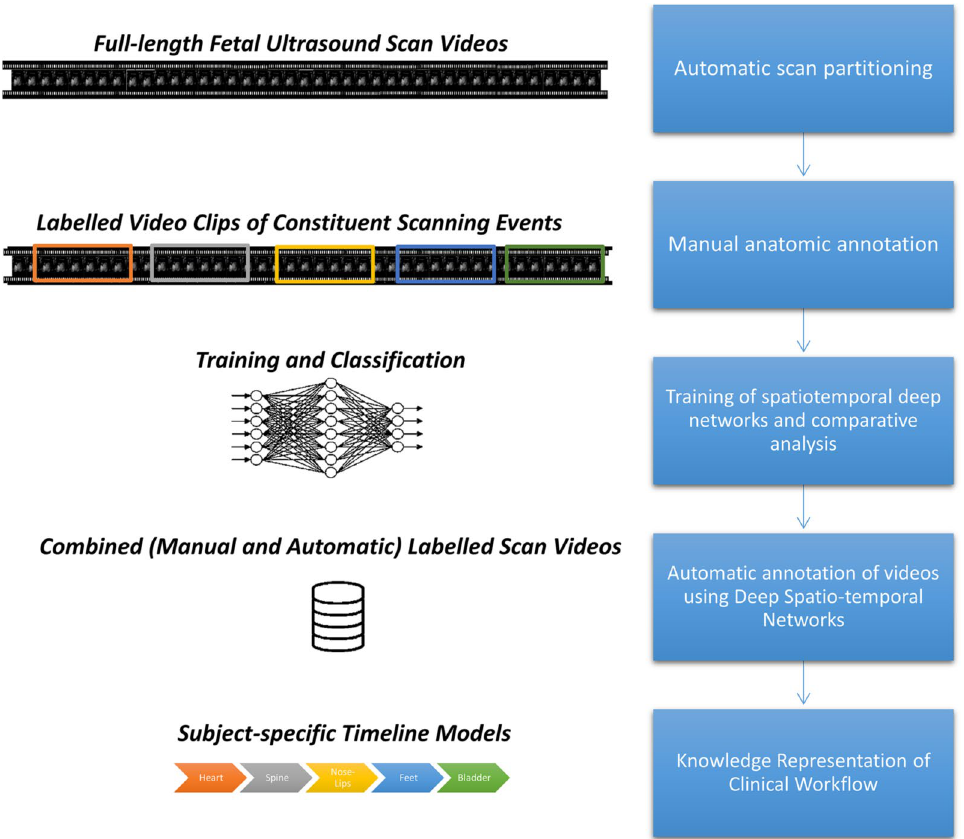
Figure 3. Outline of the clinical workflow analysis pipeline. Stepwise approach to second-trimester workflow analysis: (1) partitioning—automatically extraction of 5-s clips from the videos that represent important events; (2) manual labeling of the training dataset; (3) training a spatiotemporal deep network; (4) automatic labelling of the entire dataset; and (5) analysis of second-trimester scans as a sequence of organs being scanned. Figure created using Microsoft Office version 365 (https:// office. micro soft.